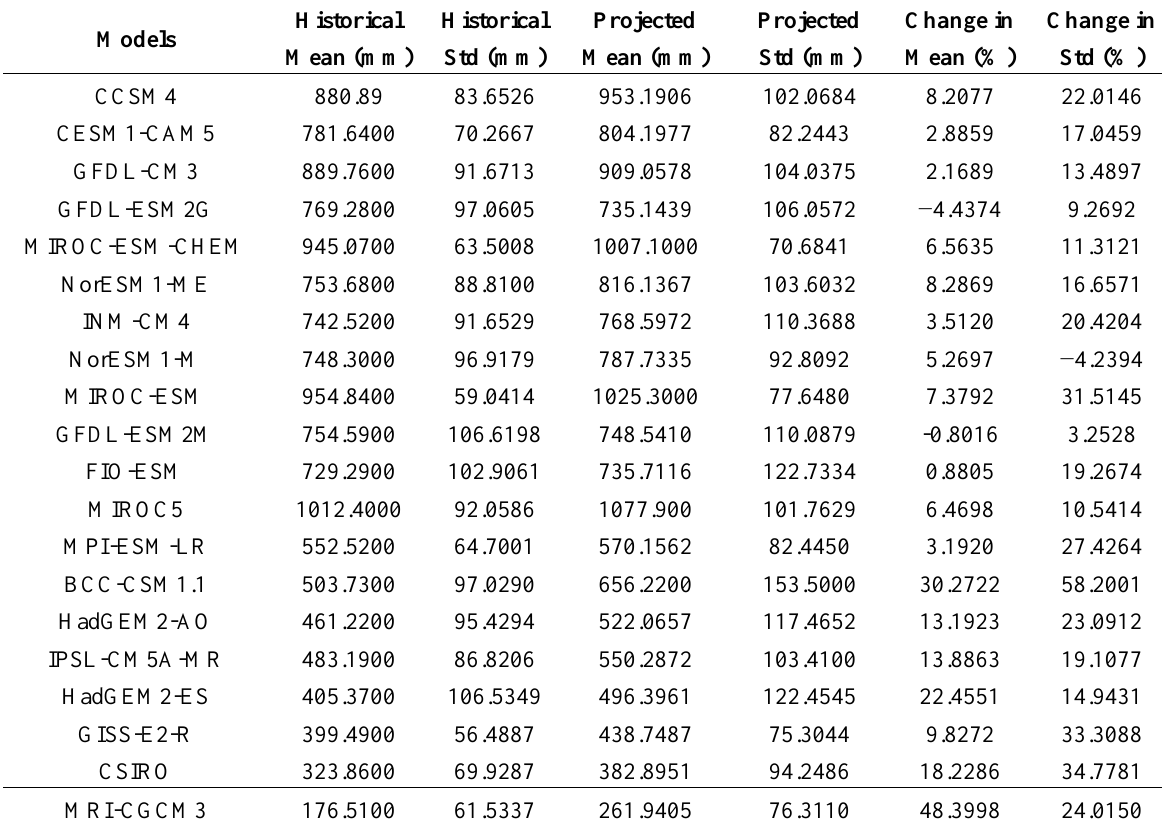
Table 3. Percentage changes in mean and standard deviation of AISMR for different models. Models